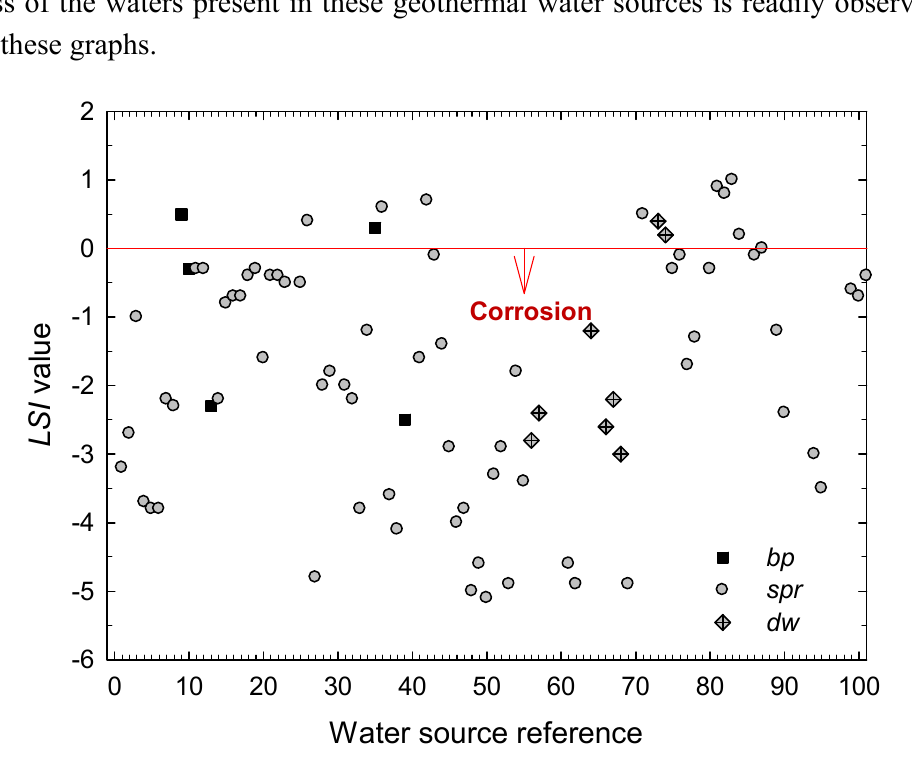
Figure 2. Distribution of the water sources in the Azores archipelago according to their Langelier Saturation Index